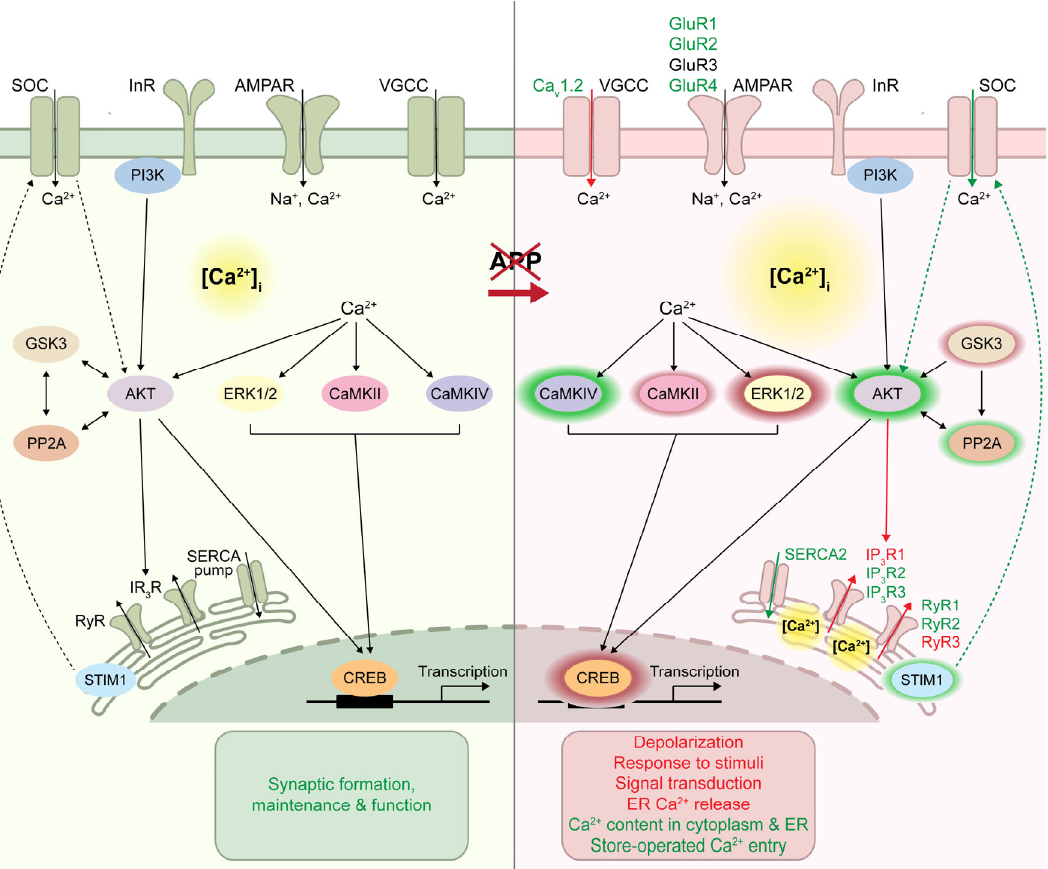
Figure 9. Schematic representation of key signal transduction players that govern Ca 2+ signaling during synaptic function and are mainly affected by APP downregulation. This illustration combines our findings with data available from the literature discussed in the text. The shaded halos shown on the right side (APP knockdown) of the image were used to surround proteins that are either upregulated (green) or downregulated (red), as evidenced by the phosphorylated/total ratio. Their size is proportional to the extent of the upregulation or downregulation. Arrows represent increases (green) or decreases (red) in the activity of the respective channels or pathways.